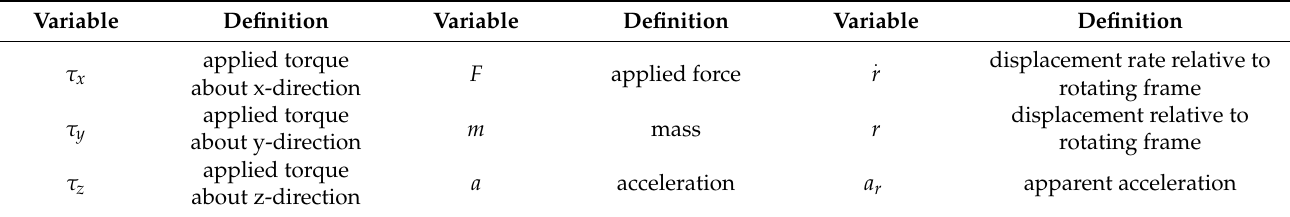
Table 3. Definitions of variables proximal to Table